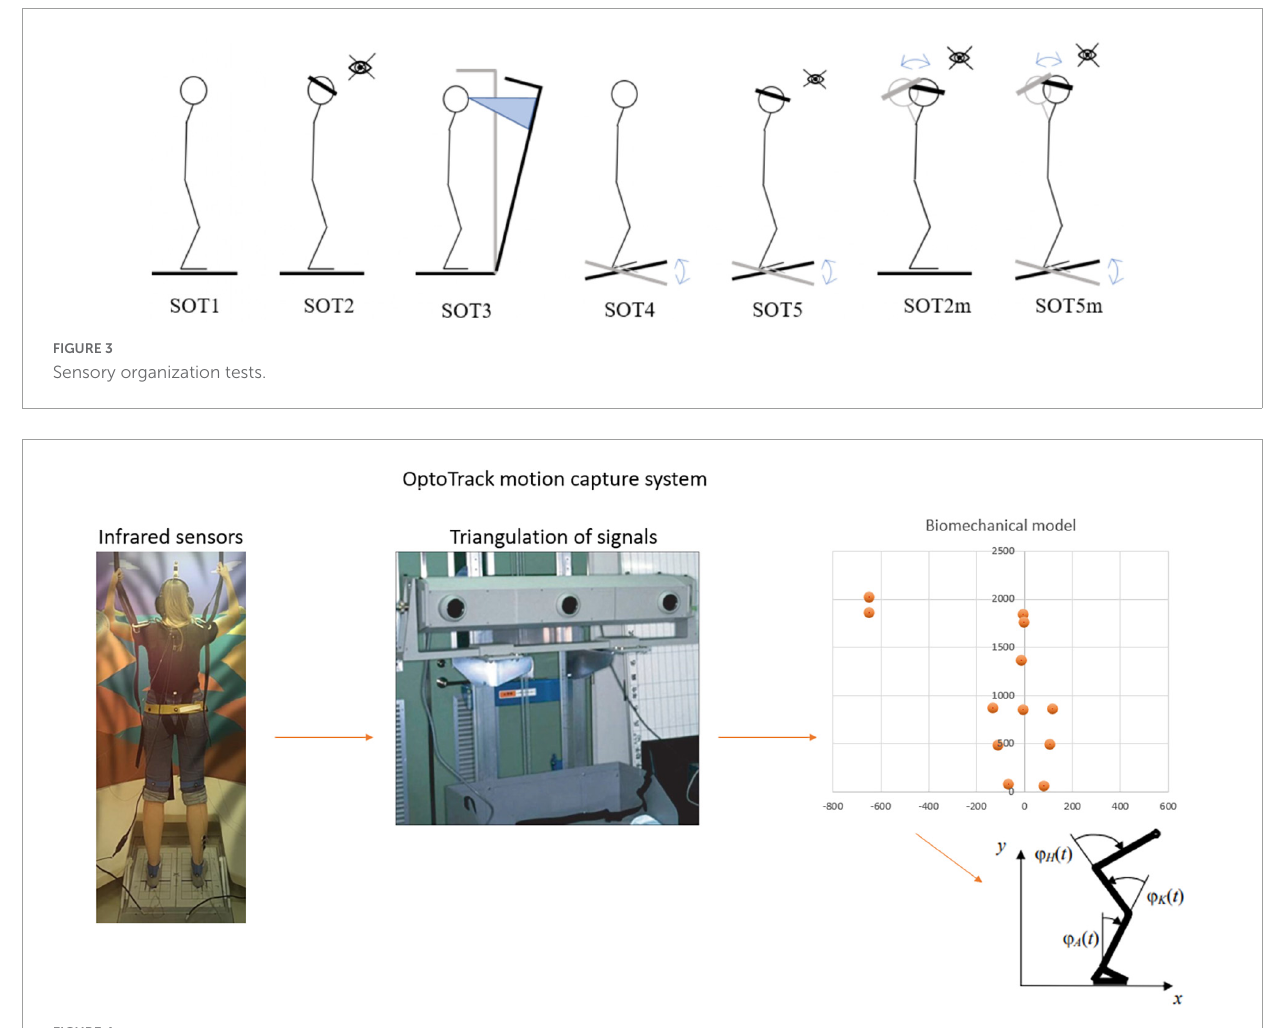
FIGURE4 Kinematic characteristics registration and